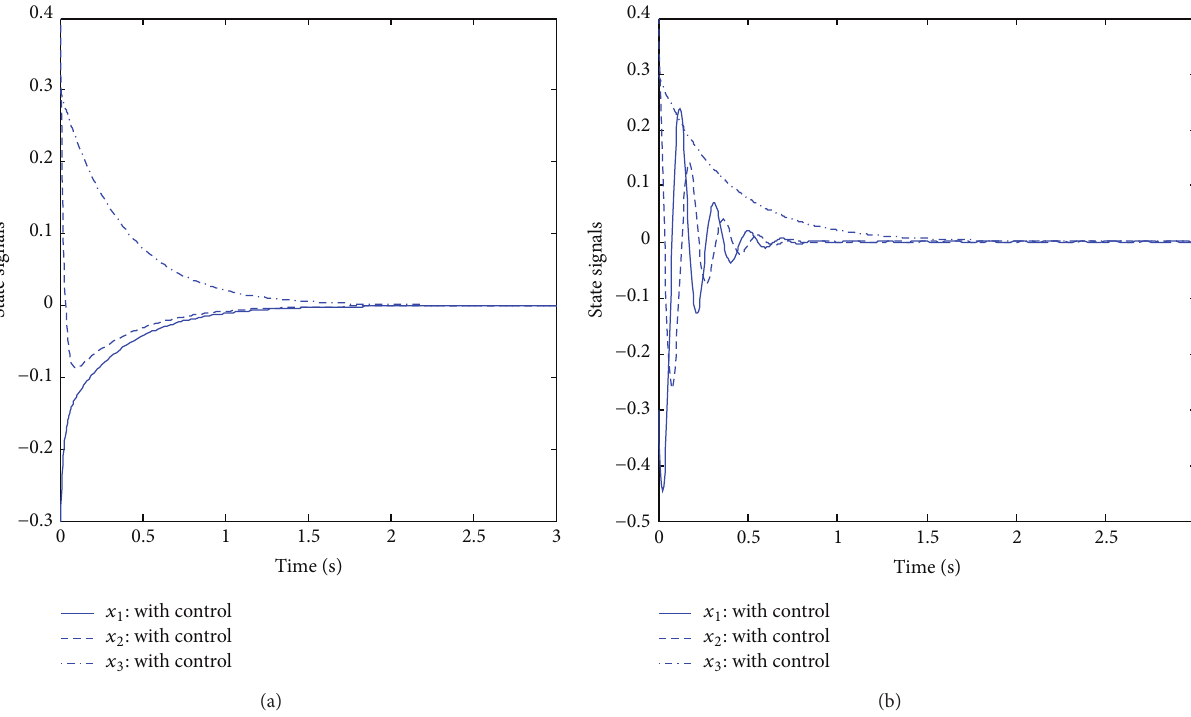
Figure 7: Transient response of state signals with (a) single input, single state, unit negative feedback 𝑢 2 = −40𝑥 2 ; (b) single input control = −2𝑥 − 50𝑥 𝑢 = 0 , and 𝑢 = 0 𝑢 1 1 2 , 2 3